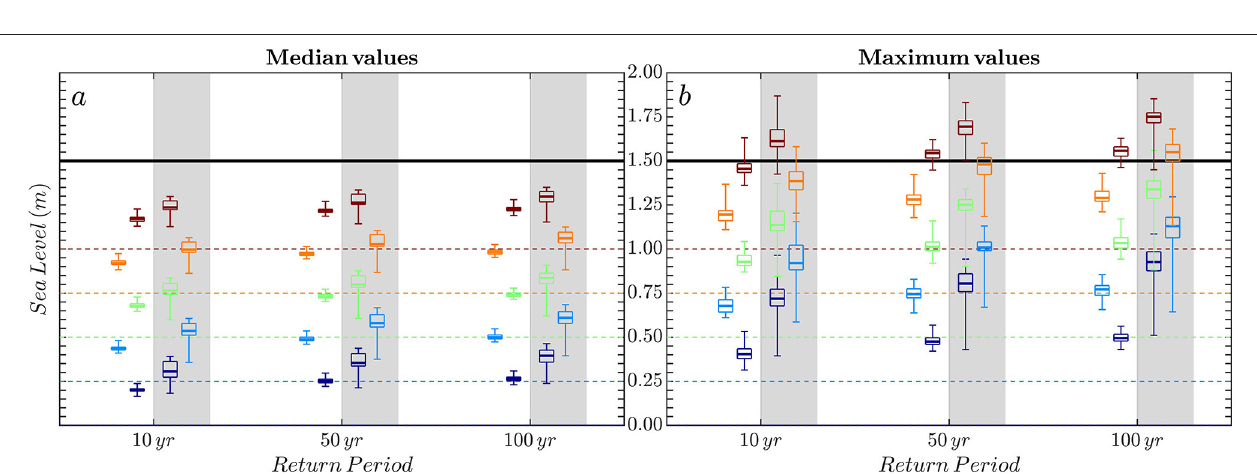
FIGURE 9 | Box plots along Hoarafushi coast without airport computed with time series of simulated water levels: (a) median values; (b) Maximum values. Box plot colours indicate the sea level of the simulation (dark blue 0 m; light blue 0.25 m; green 0.5 m; orange 0.75 m; dark red 1 m) and are referenced from the dashed line with the same colour. Box plots on grey (white) background are for the simulations for the southwestern swell (Indian Monsoon). The thicker line of the box plots shows the median values; the lower (upper) limit of the boxes indicates the 25th (75th) quantile; and the lower and upper whiskers indicate the minimum and maximum values. The horizontal thick black line indicates the island height.